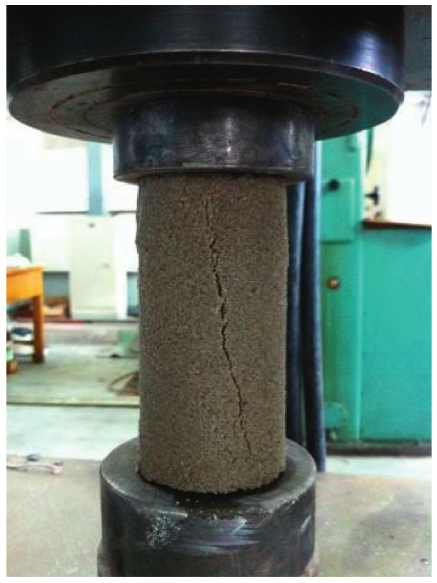
Figure 3: Failure of a saturated specimen.